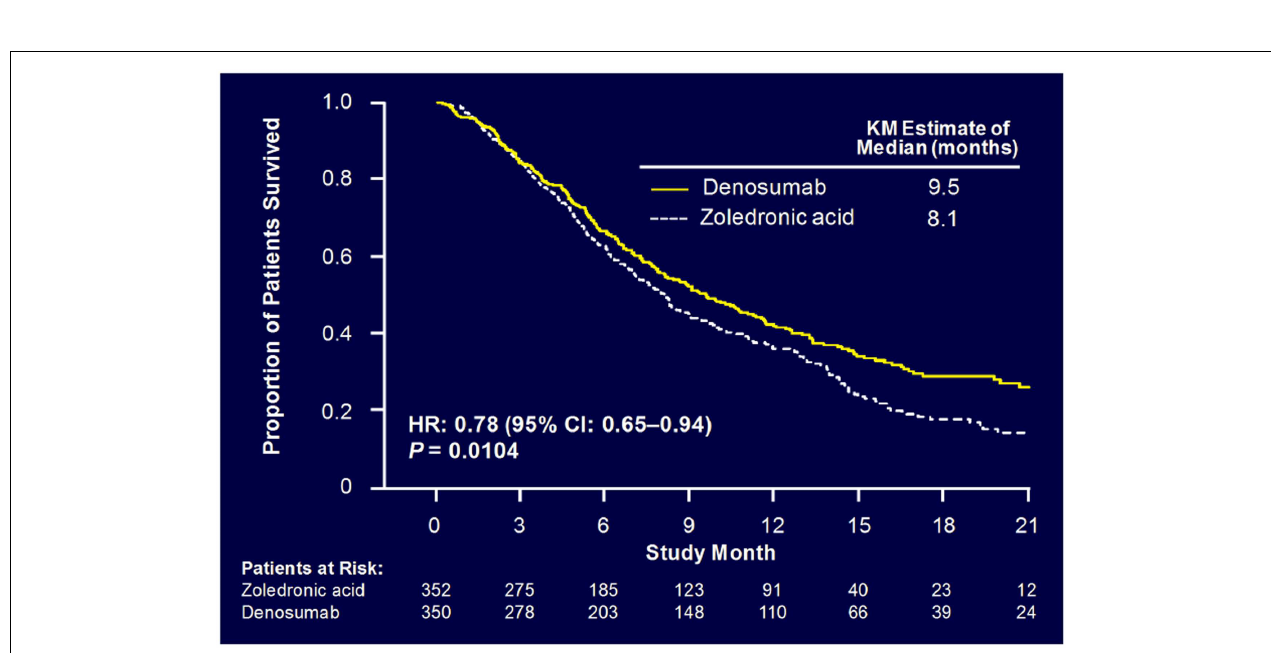
FIGURE 7 | Overall survival: patients with NSCLC